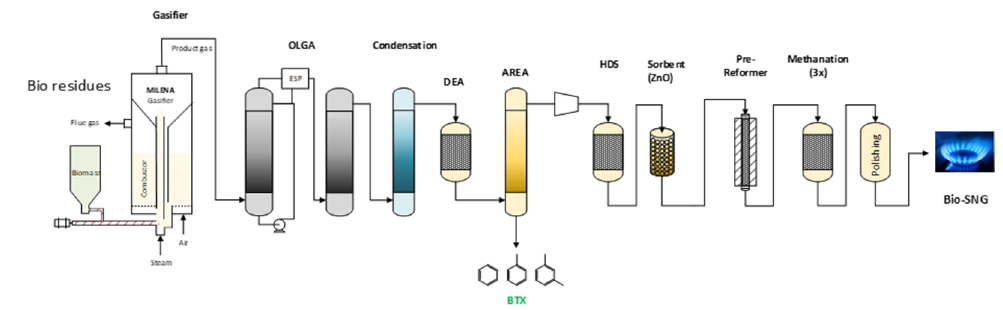
Figure 1. Bio-substitute natural gas (SNG) production route via biomass gasification developed at the Netherlands Organization for Applied Scientific Research (TNO).